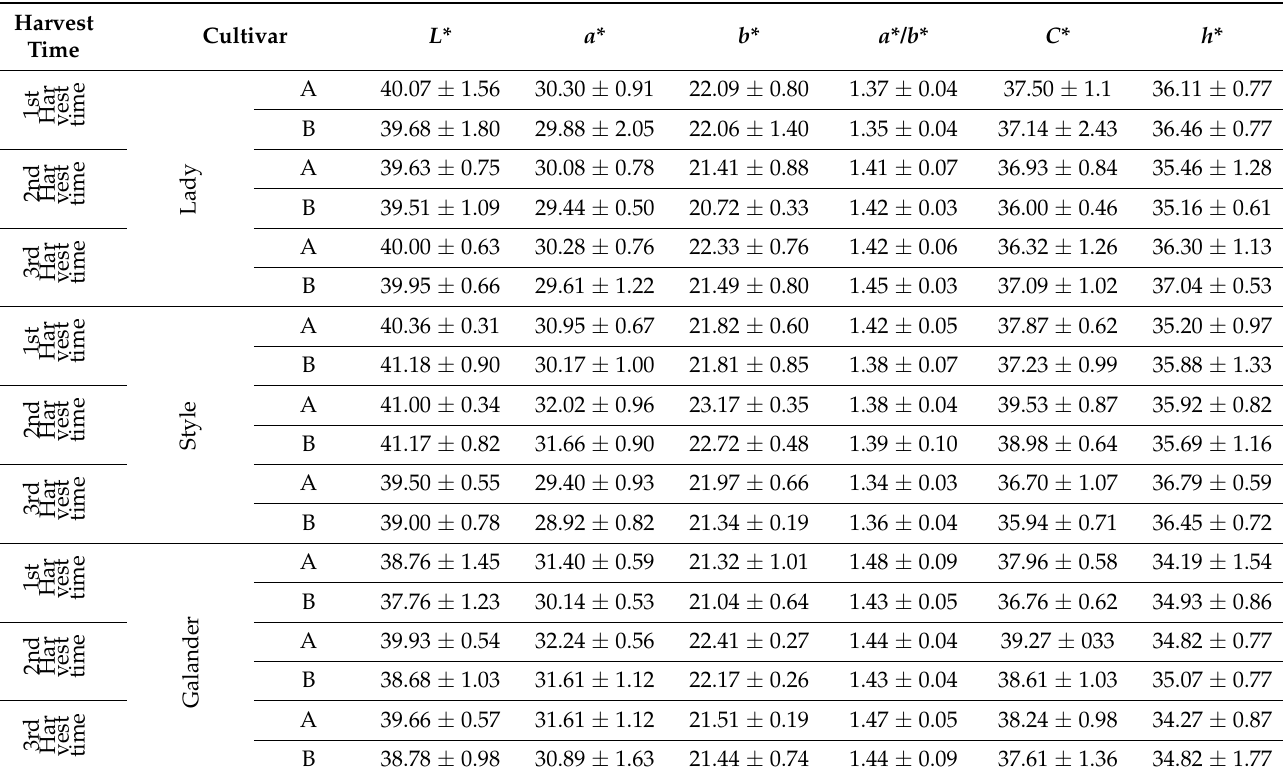
Table 1. Illustrates Avg ± SD values of L *, a *, b *, ΔE, a */ b *, C *, and h * color parameters of Lady, Style, and Galander